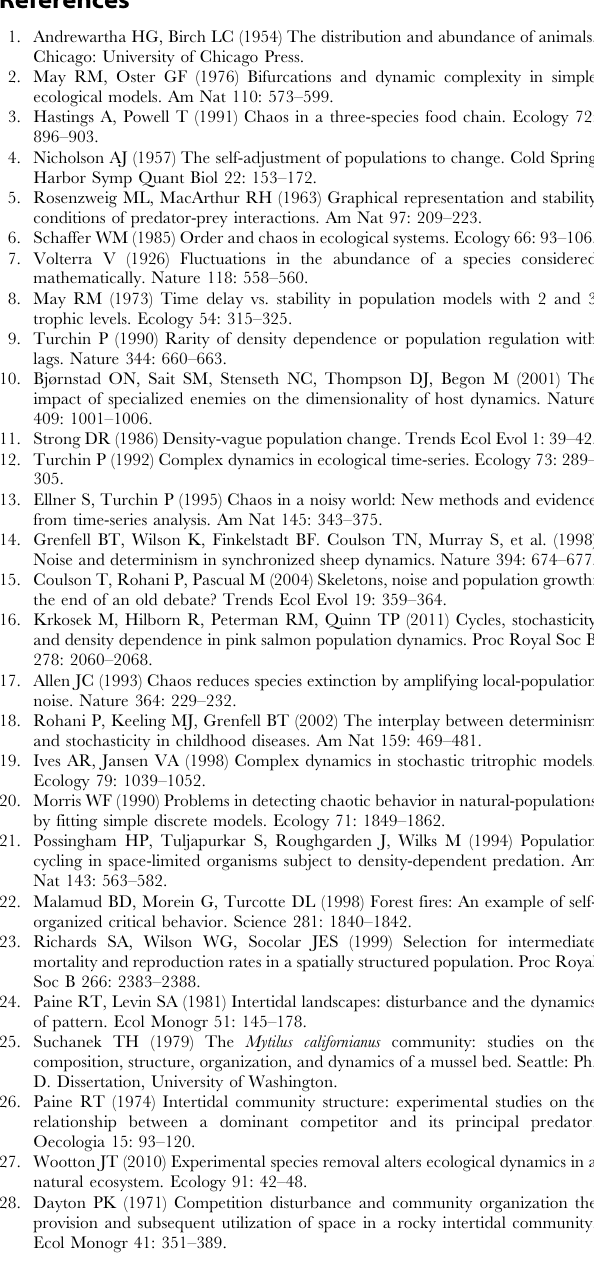
Table S1 Comparisons of best fitting (first-order, non- linear, density-linked stochastic) models for first- or fourth-order data, and parameter estimates derived from model